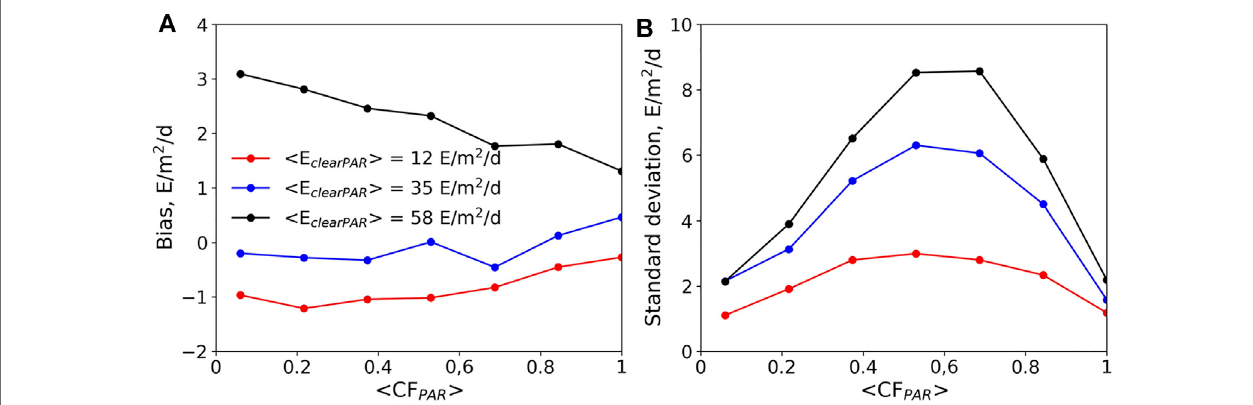
FIGURE3 | Algorithm uncertainity onindividual < E PAR > estimates (i.e., using one observation per day) asa function of < CF PAR > for several values of < E clearPAR > . (A) Bias (estimated minus simulated values); (B) standard deviation. The theoritical uncertainity was obtained from simulations of the TOA re fl ectance and < E PAR > for a wide range of situations using 10 years of MERRA-2 aerosol and cloud data (see text for details).